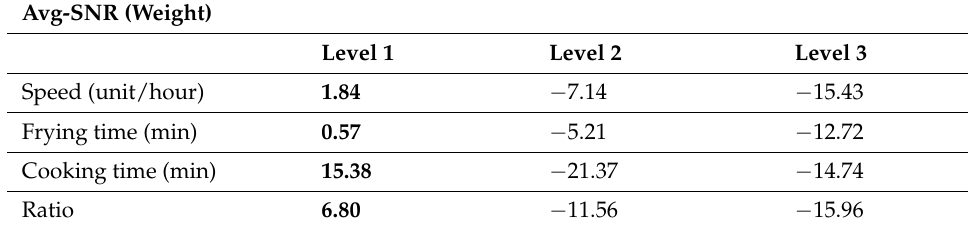
Table 8. The average SNR for weight response.